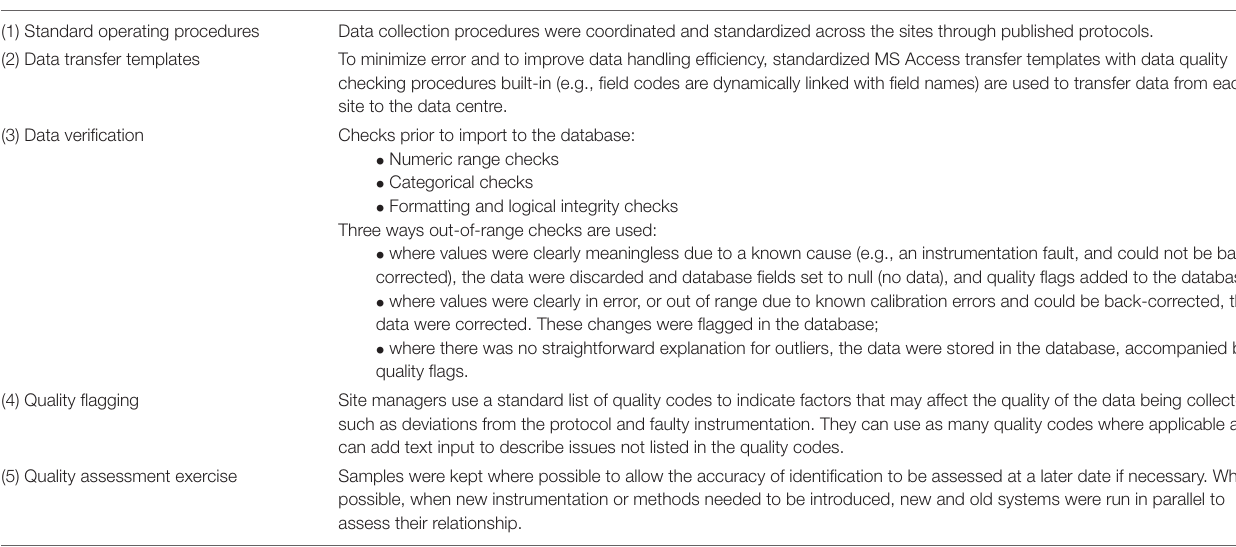
TABLE 1 | An example of data quality control at all stages of data management and collection from ECN (Rennie et al.,